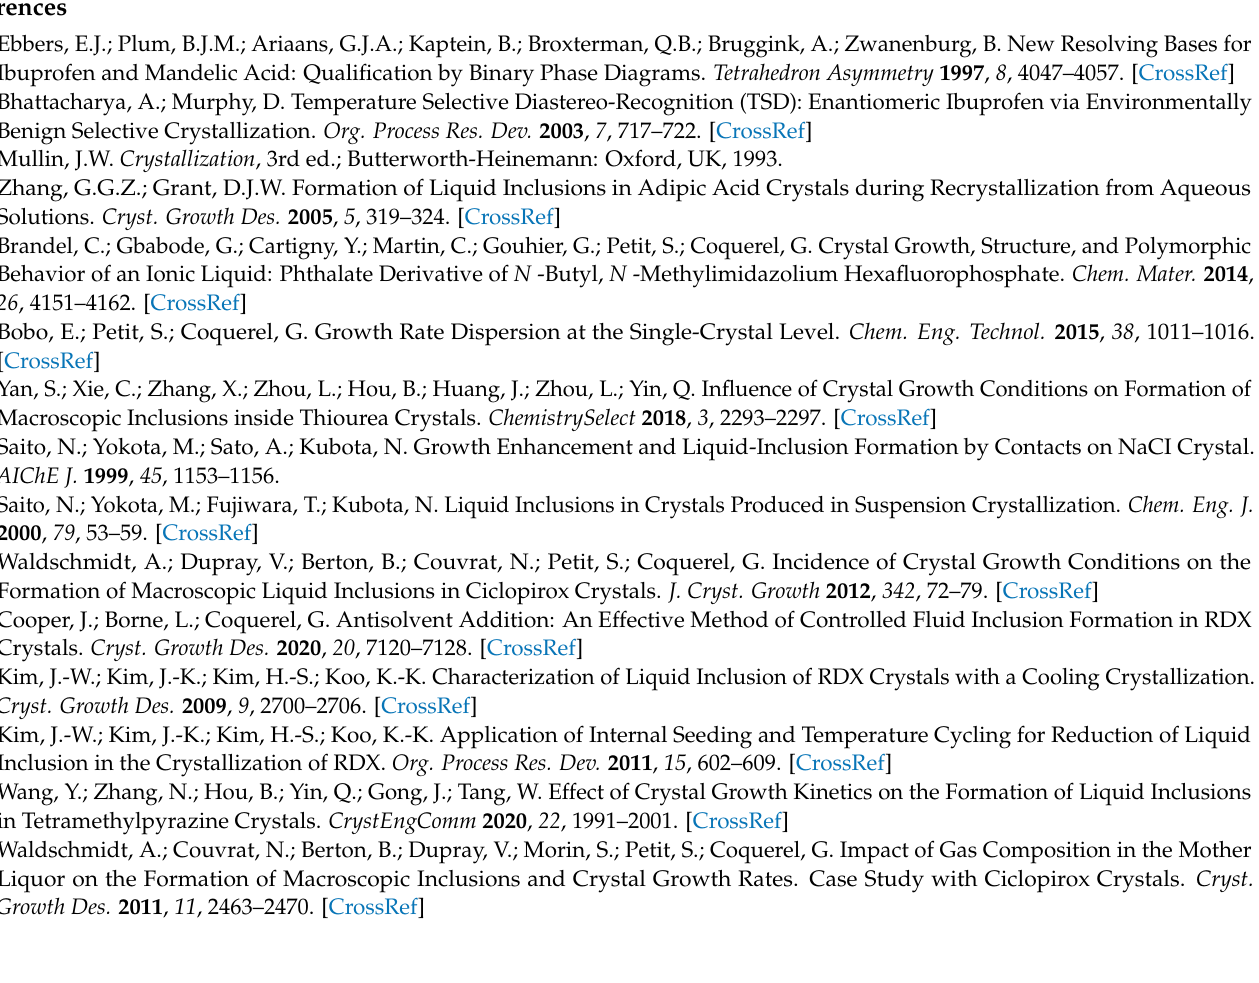
highest chiral purity obtained by chiral resolution of rac-IBU, compared with pure S-IBU/S- α MBA; Figure S2: Binary phase diagram obtained with DSC measurements in pierced pans from 20 ◦ C to 200 ◦ C at a heating rate of 2 K/min; Figure S3: Tammann graph obtained with DSC measurements in pierced pan from 20 ◦ C to 200 ◦ C at a heating rate of 2 K/min; Table S1: Eutectic composition calculated with Schröder van Laar equation; Figure S4: Mapview of the Fobs-Fcalc through C13-C2- H2 plane; Figure S5: Mapview of Fo through C13 C2 H2 atoms; Table S2: Comparison of the Ueqs; Figure S6: Inclination of the bond C*-C with reference to the ‘c’ axis; Film S1: Hot stage microscopy from 20 ◦ C to 120 ◦ C at 1 K/min on the inclusions of a crystal of